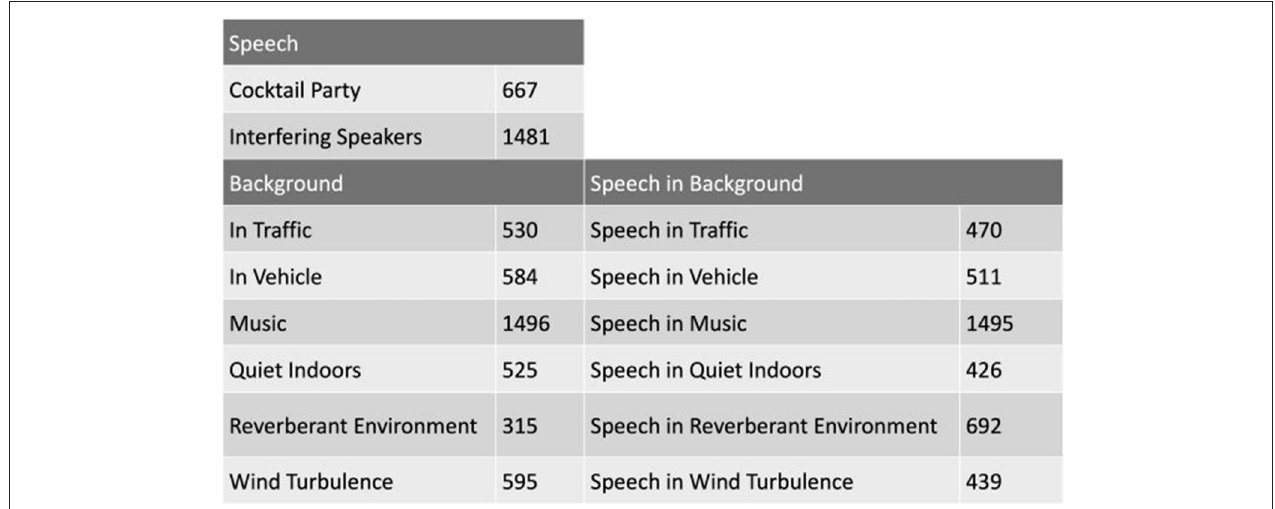
FIGURE 13 | The acoustic scenes of the HeaR-DS research data set is shown. The number next to each acoustic scene indicates the number of samples in the corresponding acoustic scene. Each sample is 10s. long.